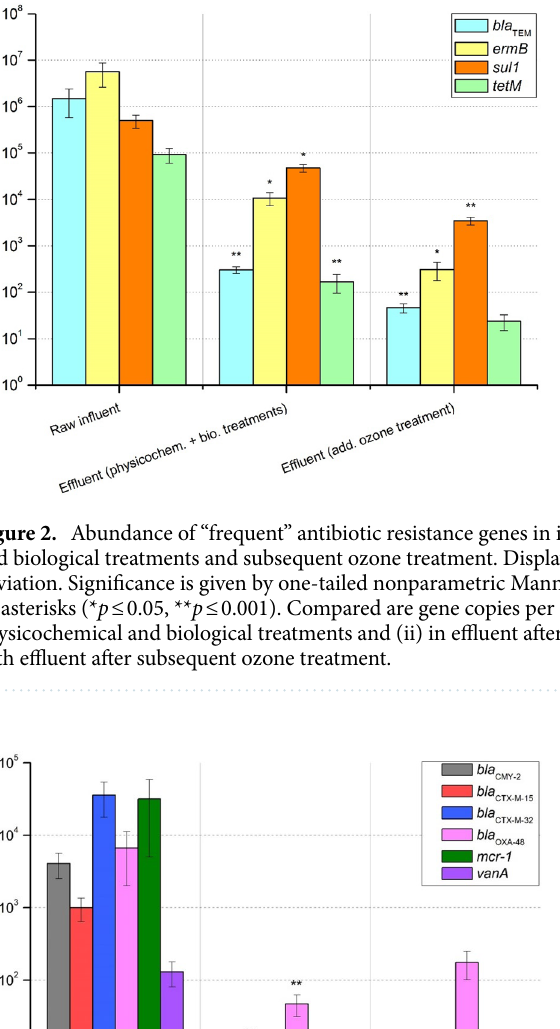
cantly reduced < LOD.